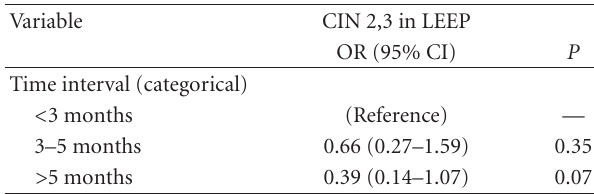
Table 4: Multivariate Regression of Time Interval and CIN 2,3 controlling for Birth Control